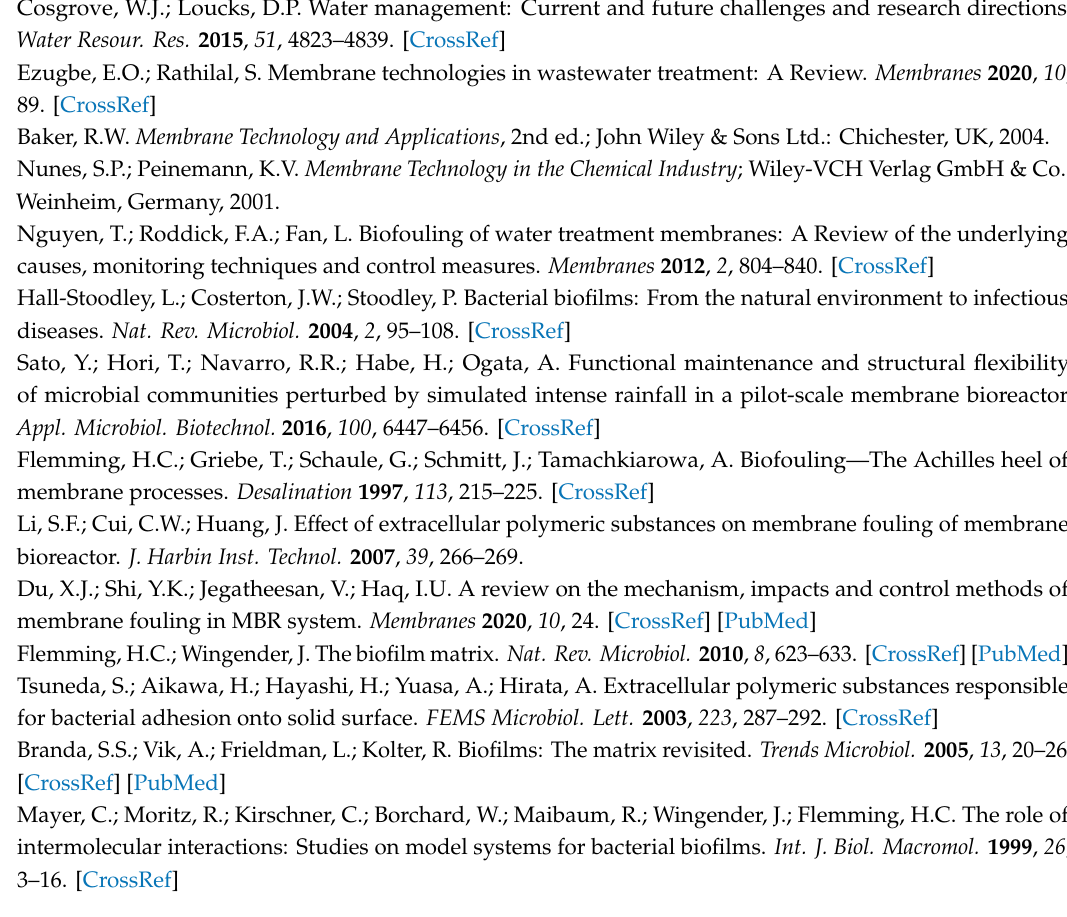
Figure S1: The colonization of polyamide membrane (PA) and cellulose acetate membrane (CA) by microbes of the activated sludge. Average ± SD of three independent experiments are